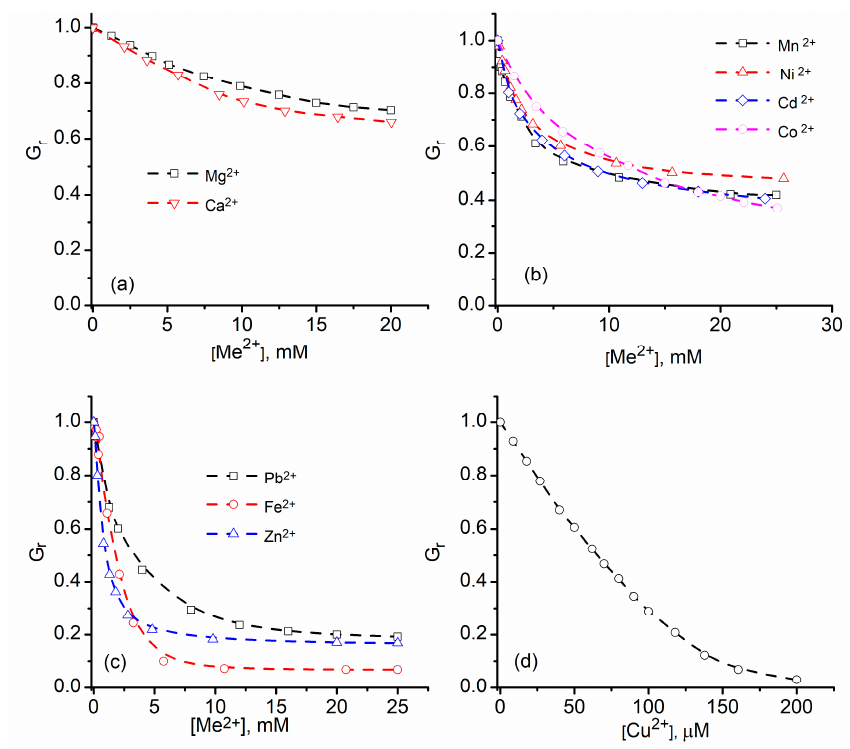
Figure 2. Divalent metal cations inhibit the macroscopic conductance of lysenin channels in